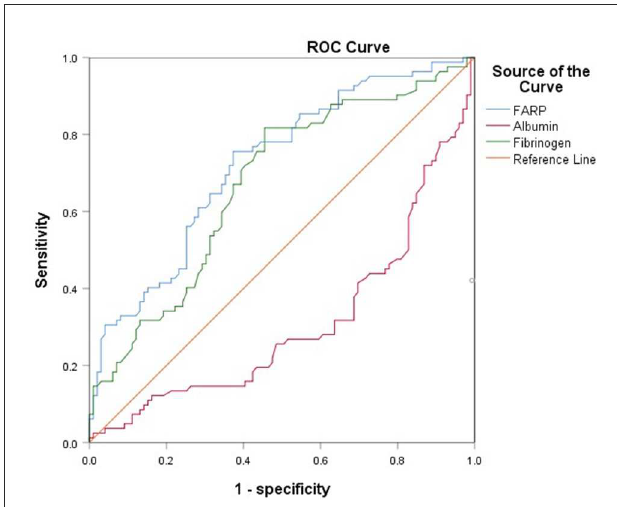
FIGURE2 The ROC curve of FARP predicts the severity of anti-NMDAR encephalitis.